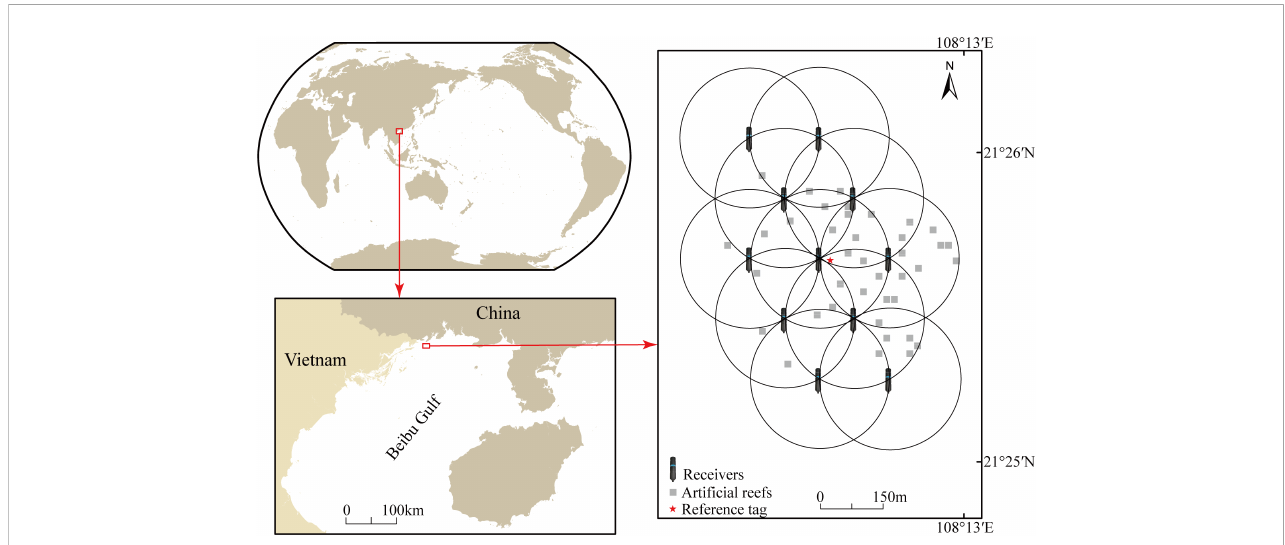
FIGURE 2 Map of the study area located in Beibu Gulf, northern South China Sea. The 11-receiver array was placed in polygons between July and September 2017. A reference tag was placed at the center of the array.